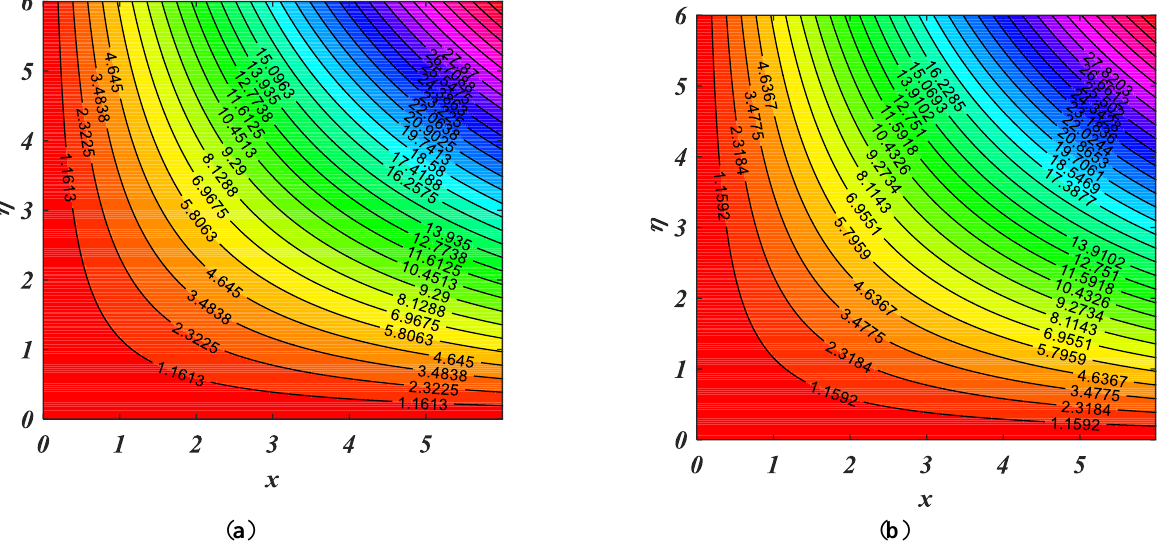
Figure 12. ( a – d ) Fluctuation in bar graphs for 𝑅𝑒 𝑥1/2 𝐶𝑓 𝛼 .